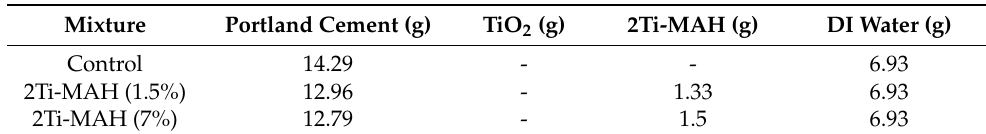
Table 2. Mixture designs’ additional testing.